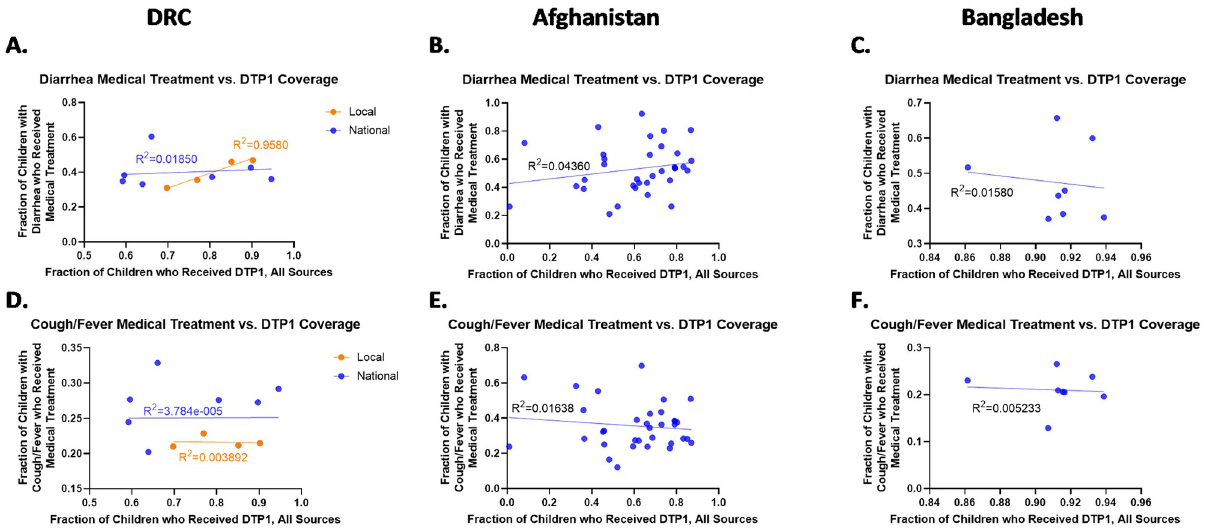
Fig 1. Linear regression between DTP1 coverage and medical treatment for diarrhea and for cough/ fever. Columns show results for DRC (A, D), Afghanistan (B, E) and Bangladesh (C, F), respectively. When examined at the subnational level throughout the whole country no linear trends were observed. However, specific crisis regions within DRC did show a strong linear relationship between DTP1 and medical treatment for diarrhea.